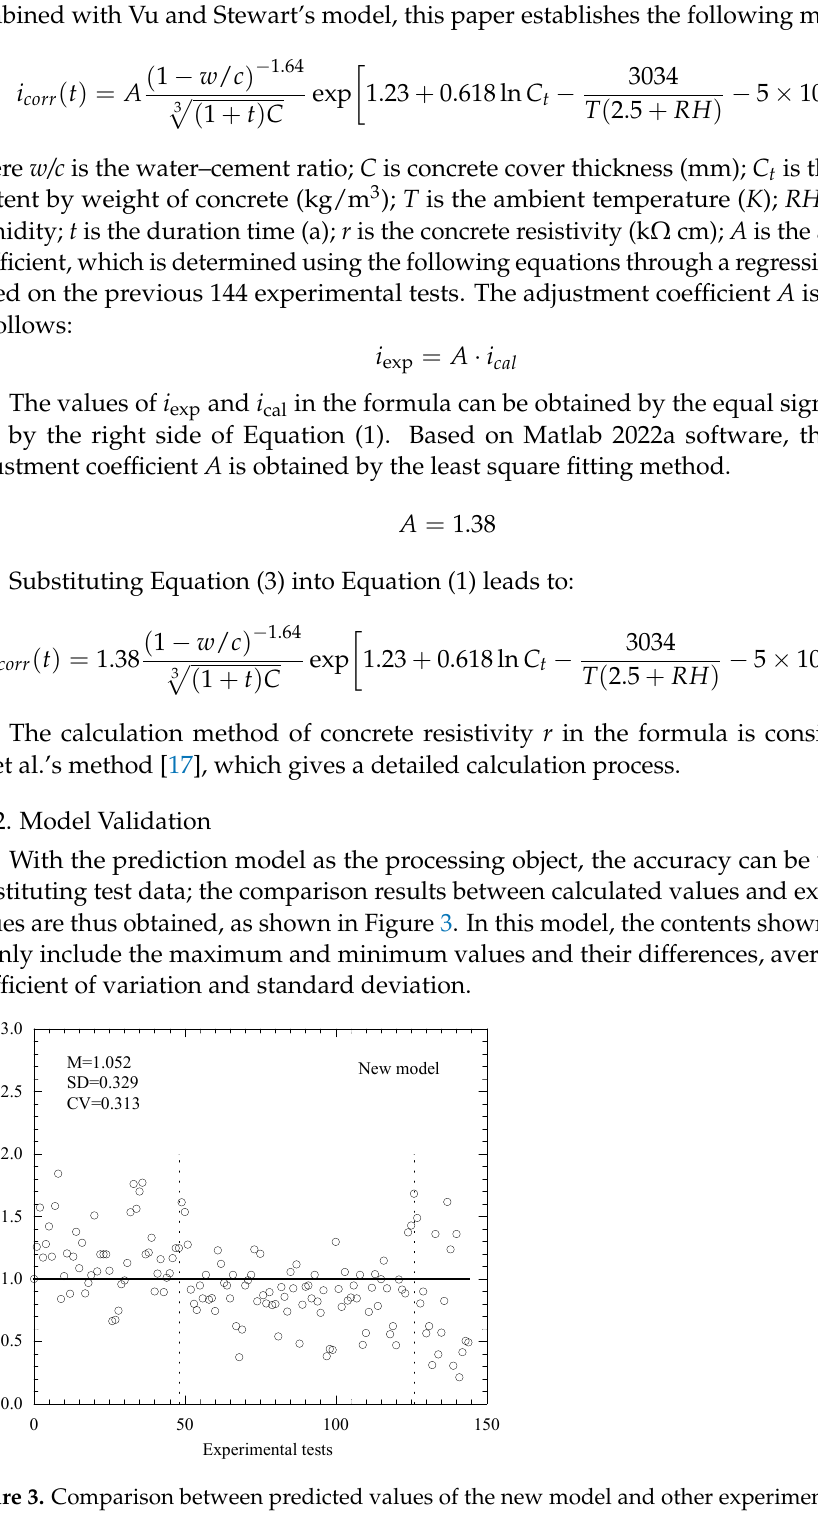
Figure 3. Comparison between predicted values of the new model and other experimental values.